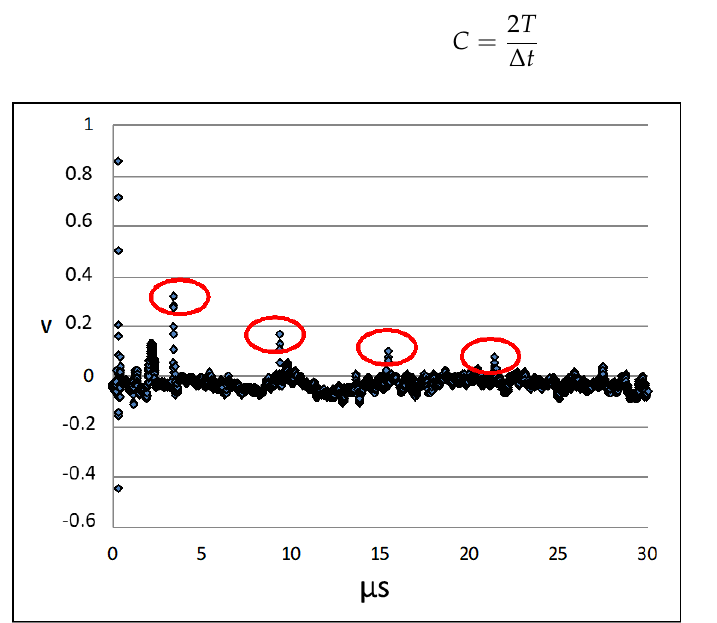
Figure 4. Laser vibrometer displacement following a laser pulse. The detected signal is measured in arbitrary unit. The principal signal and the subsequent reflections are highlighted by the red circles. In the figure, a strong initial peak is clearly recognizable at time equal to 0 s, it is maybe due to electromagnetic